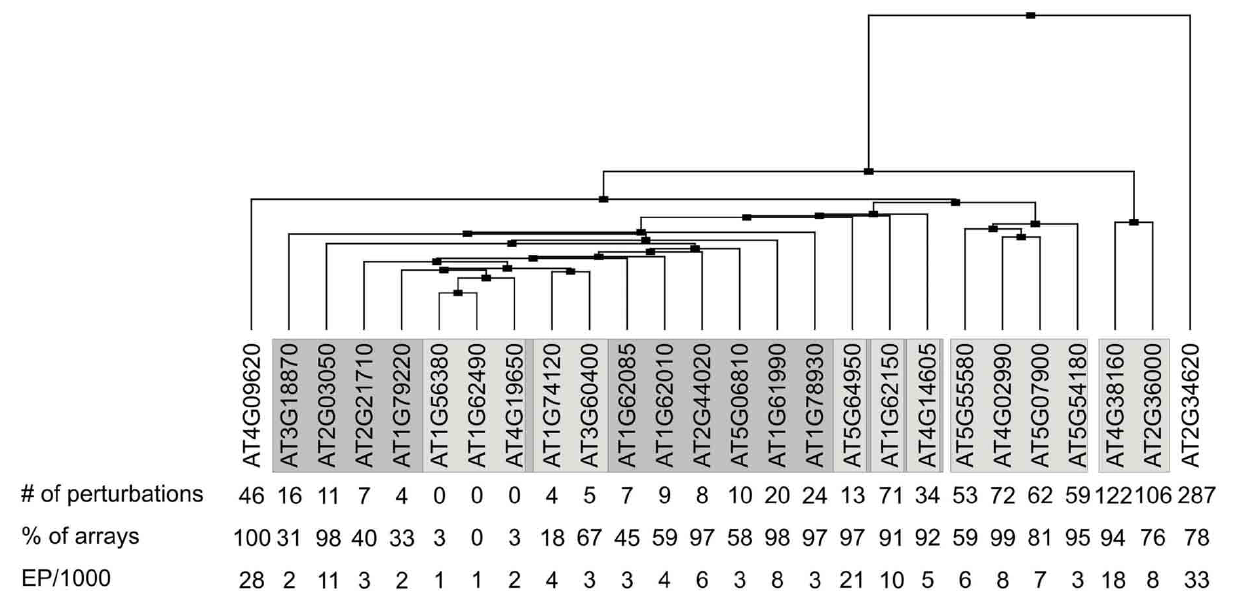
FIGURE 3 | Clustering of transcriptional responses of A. thaliana MTERF genes to different perturbations. The Genevestigator Perturbations Tool was applied to all available A. thaliana microarrays in combination with the two-fold change filter and a p -value of < 0 . 05. The cladogram at the top summarizes the relatedness of MTERF responses. number of perturbations,